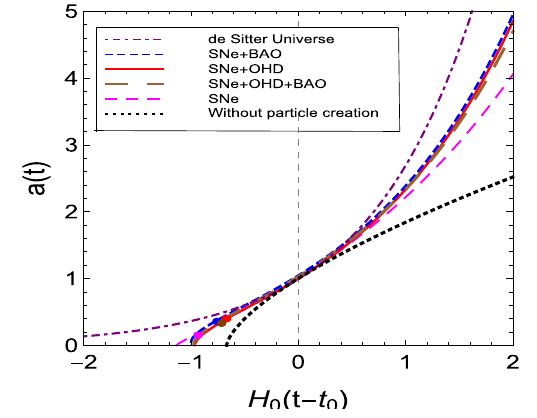
Fig. 6 The deceleration parameter as a function of redshift for best-fit values of model parameters obtained from observational data. A dot denotes the current value of q (hence q 0 )